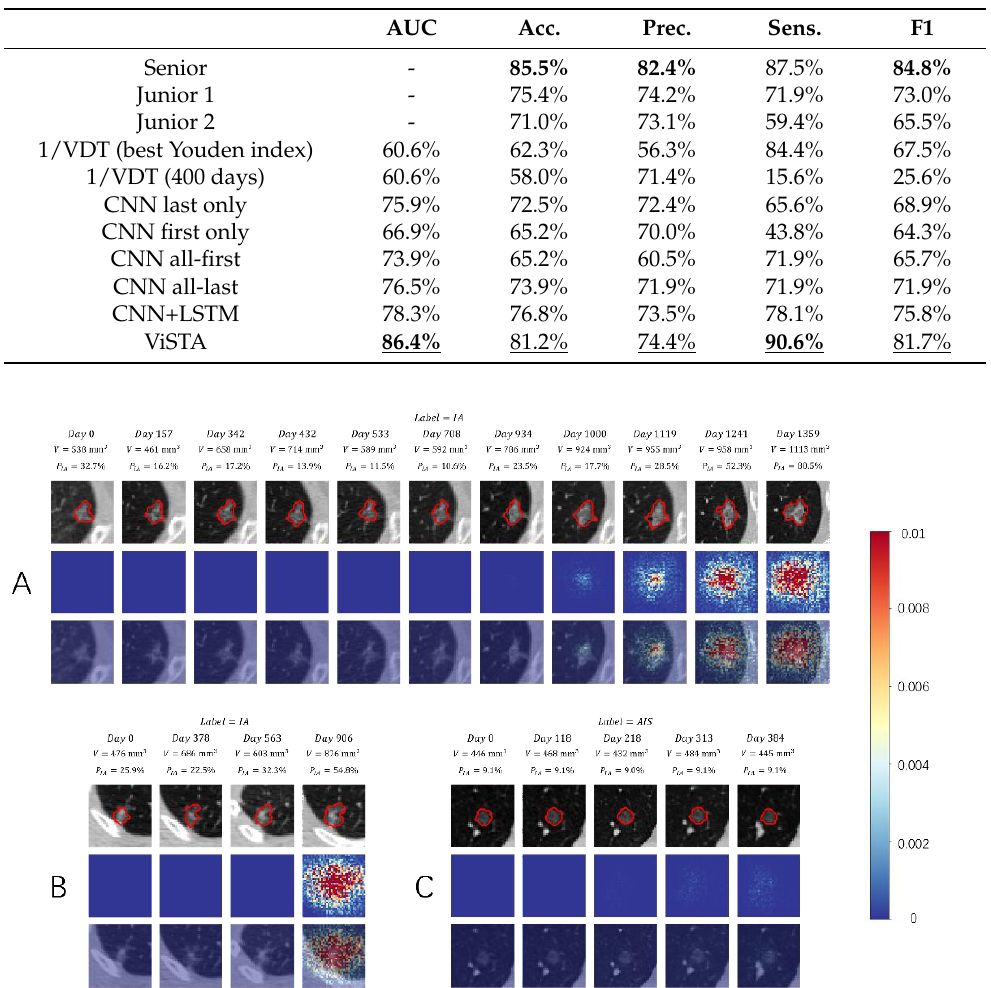
Table 2. The performance of different models and radiologists on the test dataset. The highest among all is highlighted in bold, and the highest among models and VDT (Volume Doubling Time)-based methods is highlighted with an underscore.